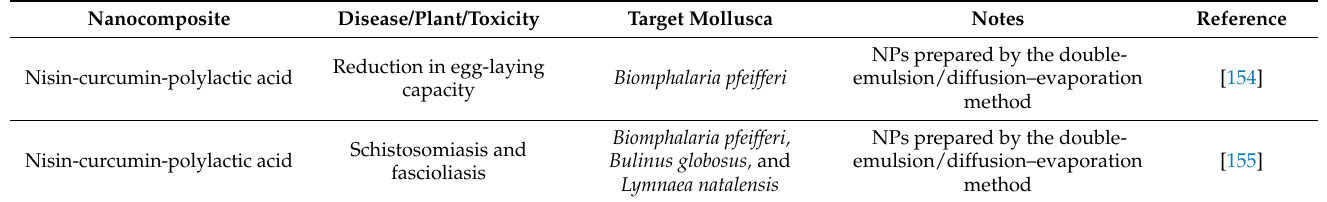
Table 6. Biopolymeric nanoparticles studied as carriers of nanomolluscicides.